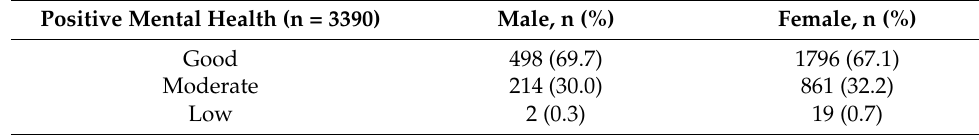
Table 6. Positive mental health levels with variables such as gender, home, and